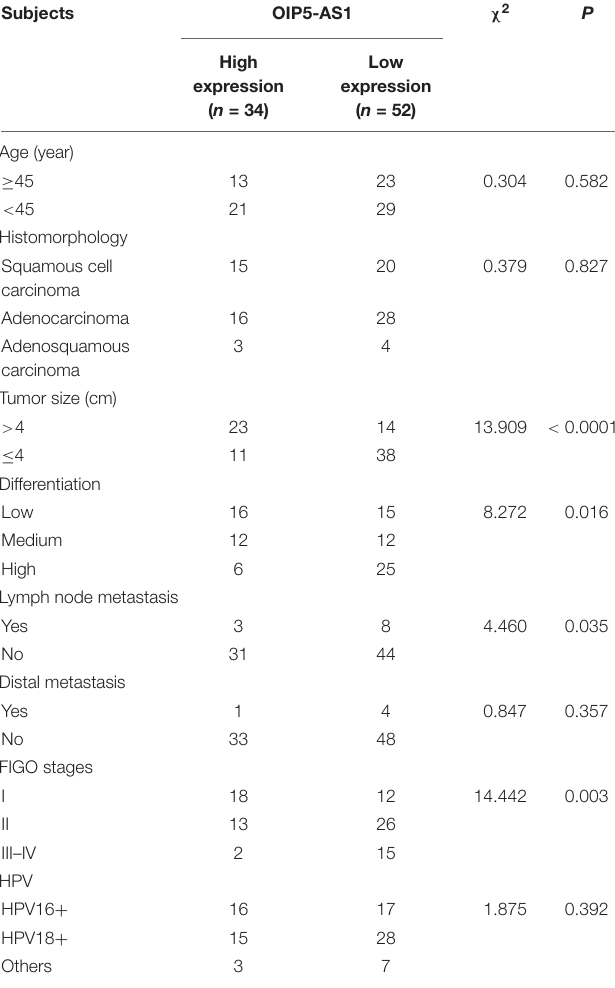
TABLE 3 | Relationship between lncRNA OIP5-AS1 expression and clinical data of cervical cancer patients ( n